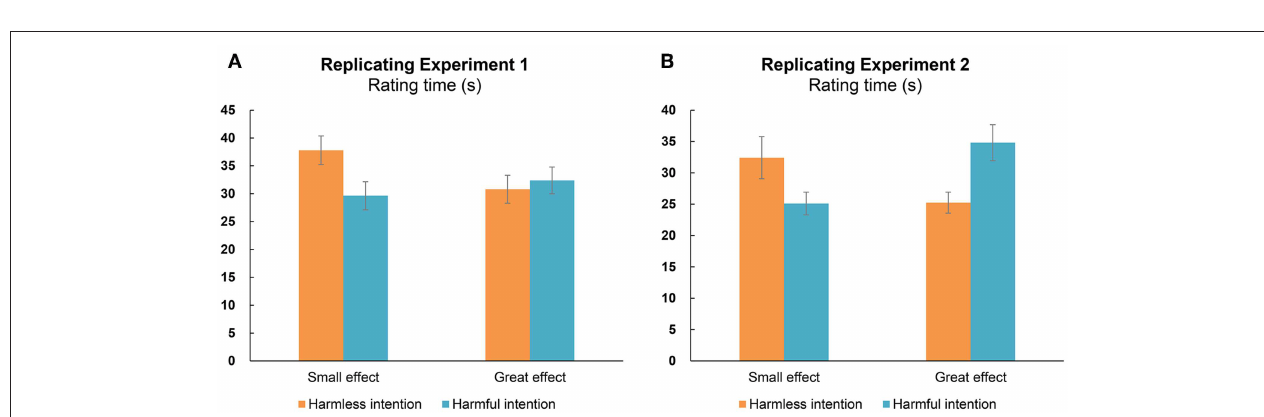
Frontiers in Psychology |